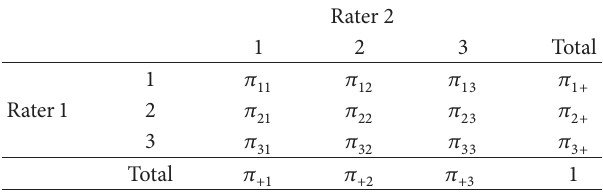
Table 1: Notation for a 3 × 3 agreement table with